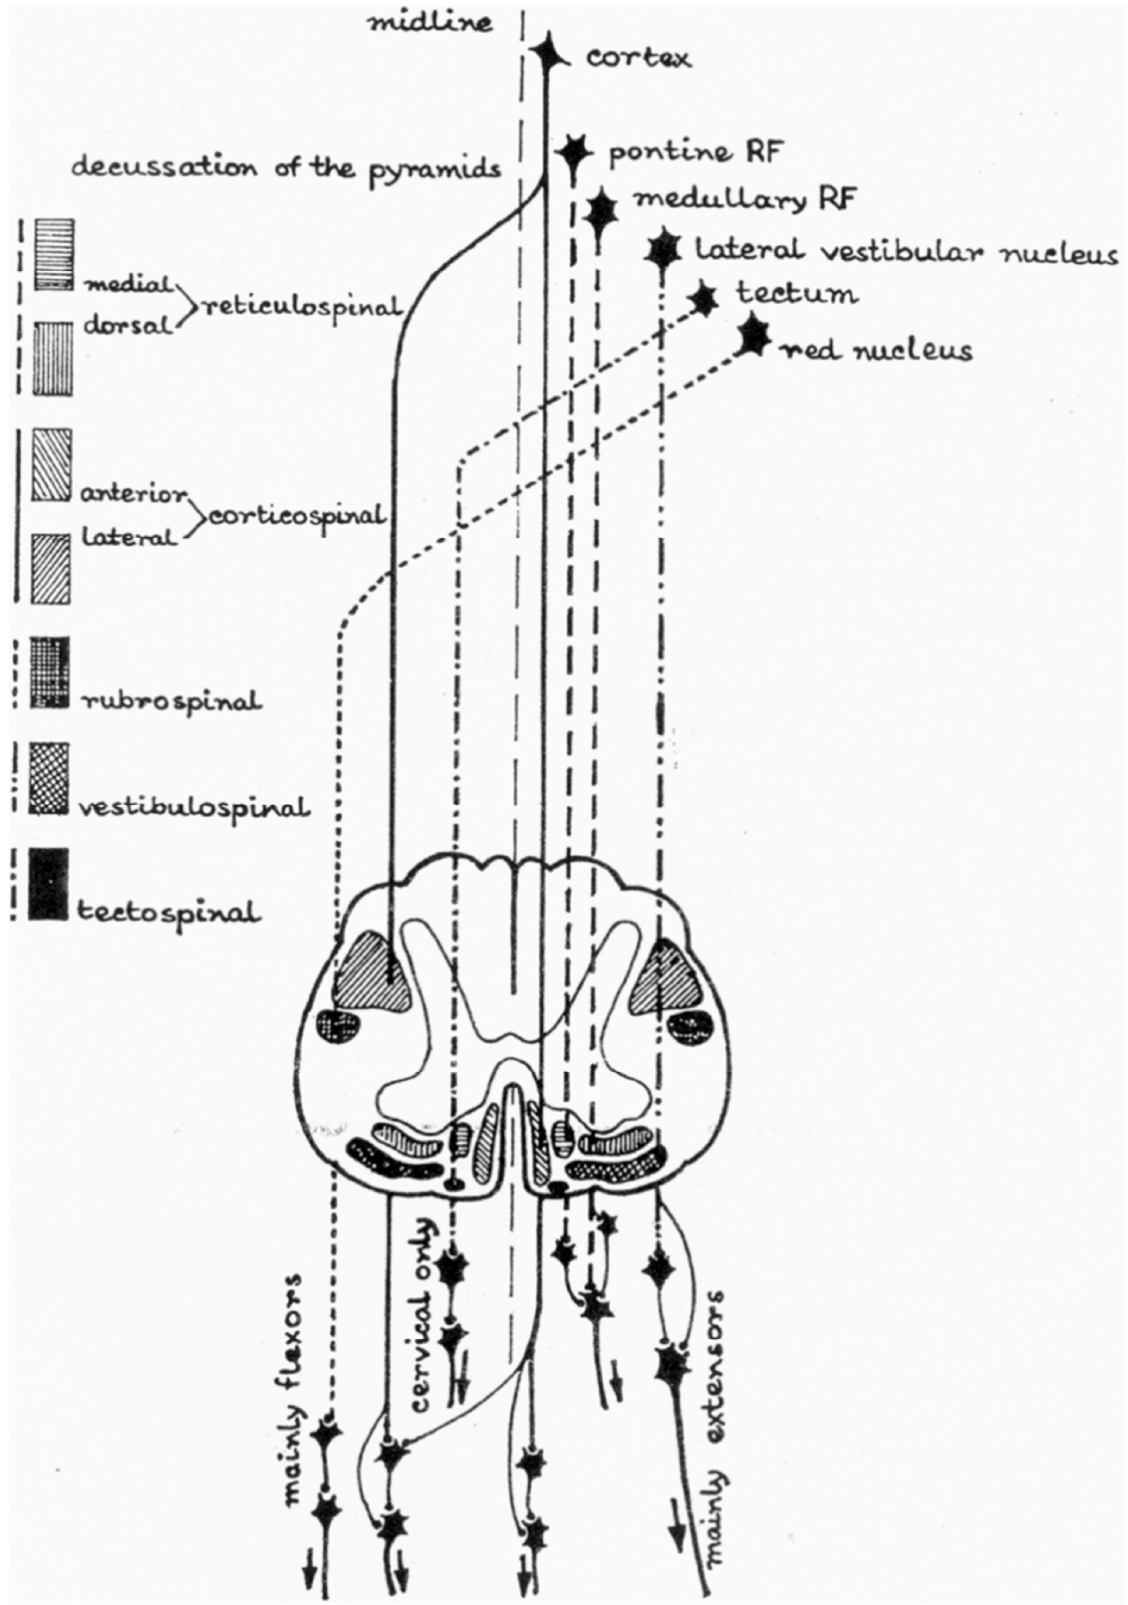
Figure 1. Diagrammatic representation of a muscle spindle. Adapted with permission from [7] Mukherjee and Chakravarty. Frontiers in Neurology 2010; 1: 149.